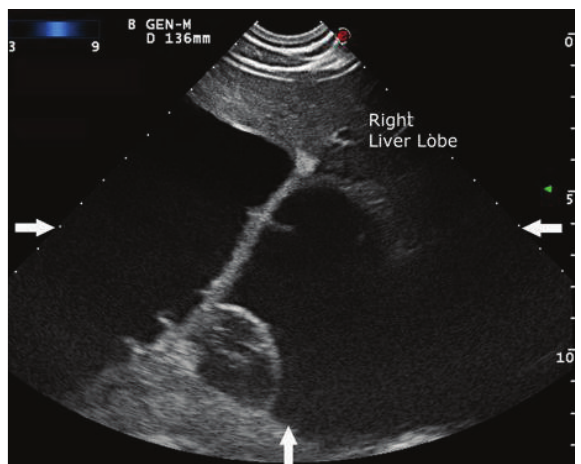
Figure 1: Ultrasound image obtained from the right cranioventral abdomen using a 3–9 MHz “microconvex” curvilinear transducer at a depth of 13.6 cm. The large cyst (arrows) can be seen originating from the right liver lobe.